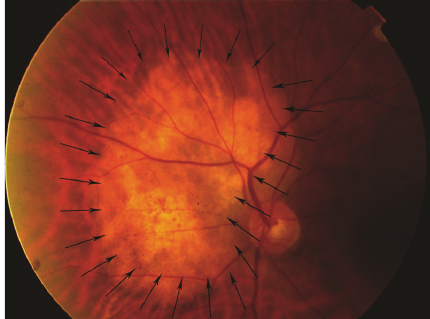
Figure 1: Fundus photo revealed the presence of a choroidal yellow- white elevated lesion, superior-nasal to the disc, with an orange pigmentation on its surface.